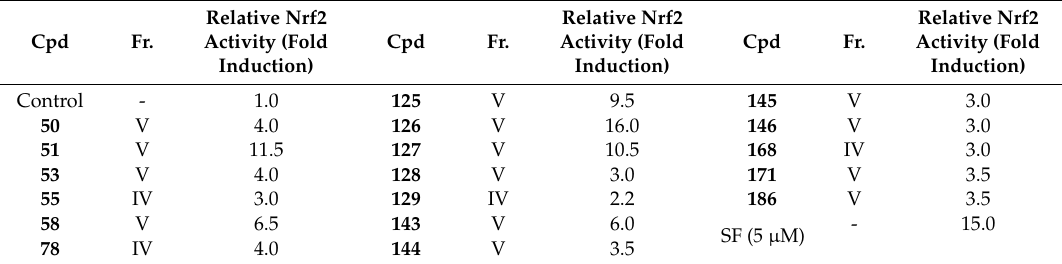
Table 4. Relative Nrf2 activity induced by compounds (40 µ g / mL) isolated from Jing liqueur.